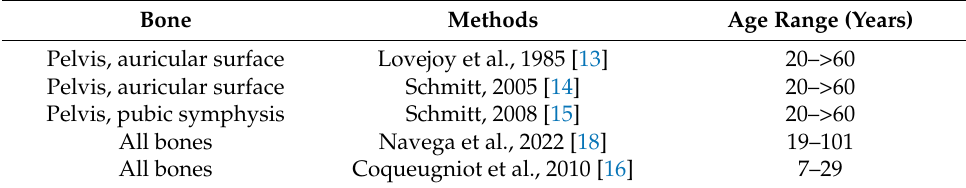
Table 2. Methods used for age estimation and determining age range.